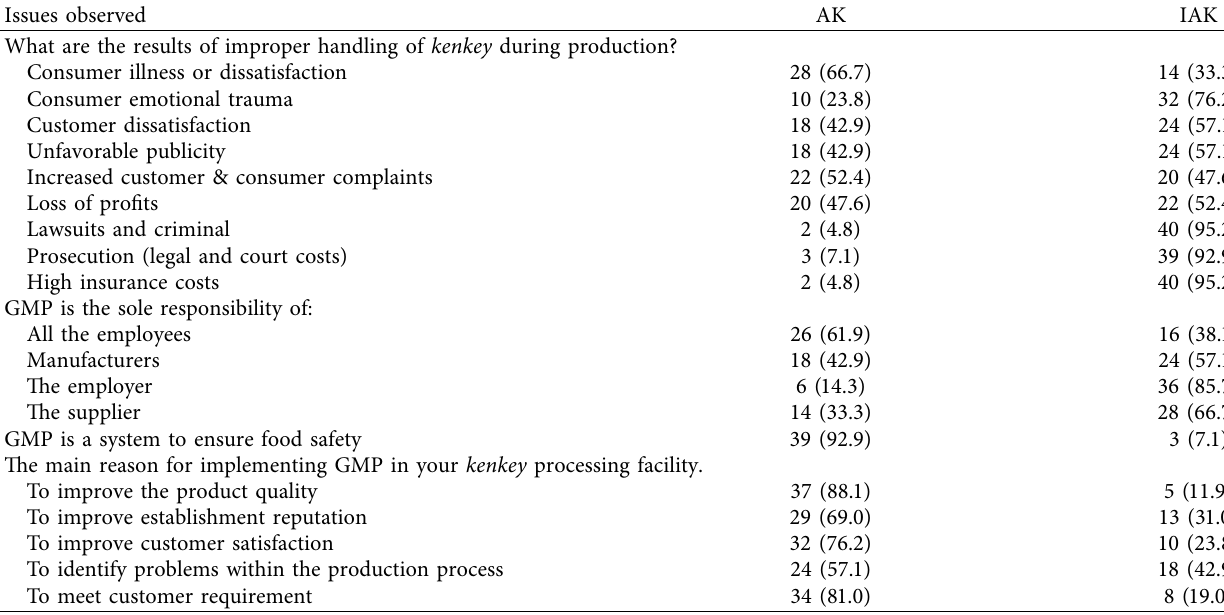
Table 4: Producers’ knowledge of good manufacturing practices (GMP) in